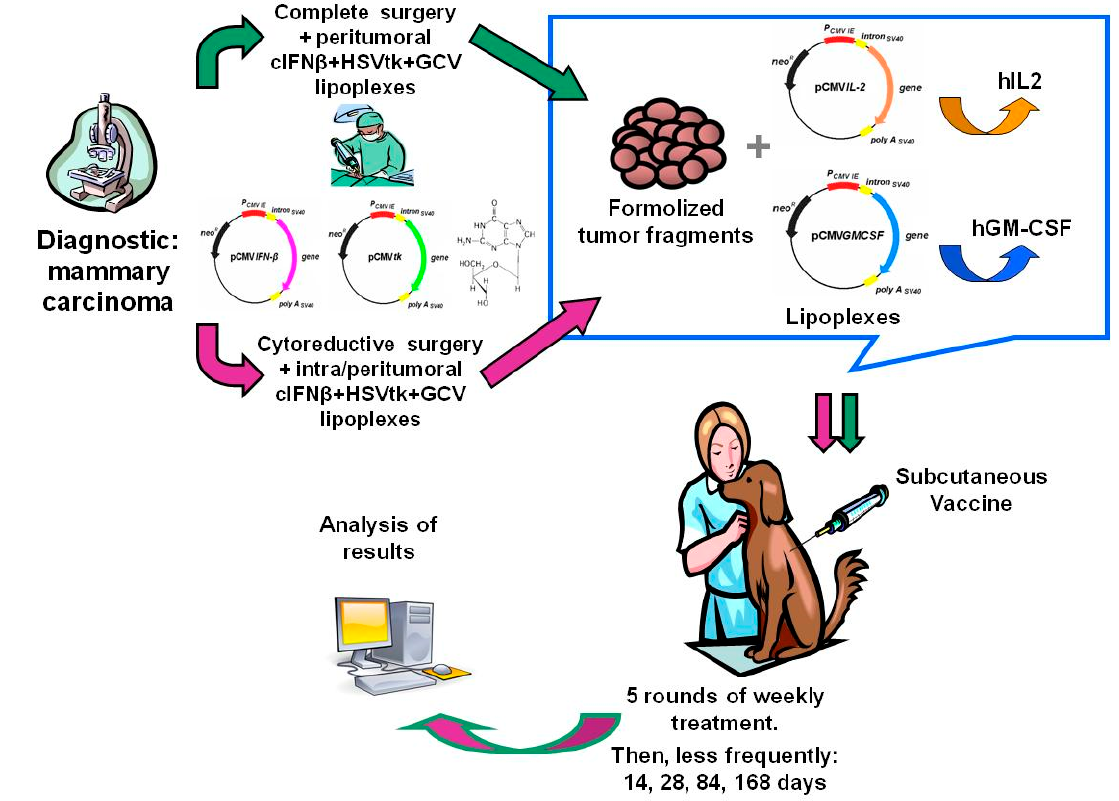
Figure 1. Diagram of the combined gene therapy as a surgery adjuvant.